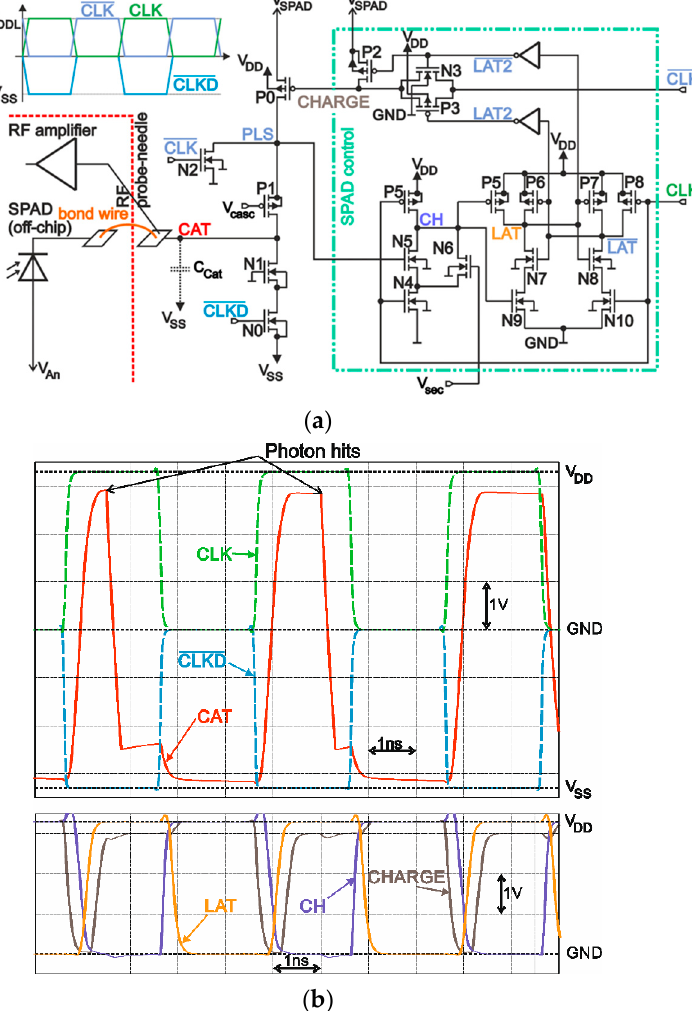
Figure 3. SPAD control in the gating control chip: ( a ) Schematics; ( b ) Simulated transients assuming